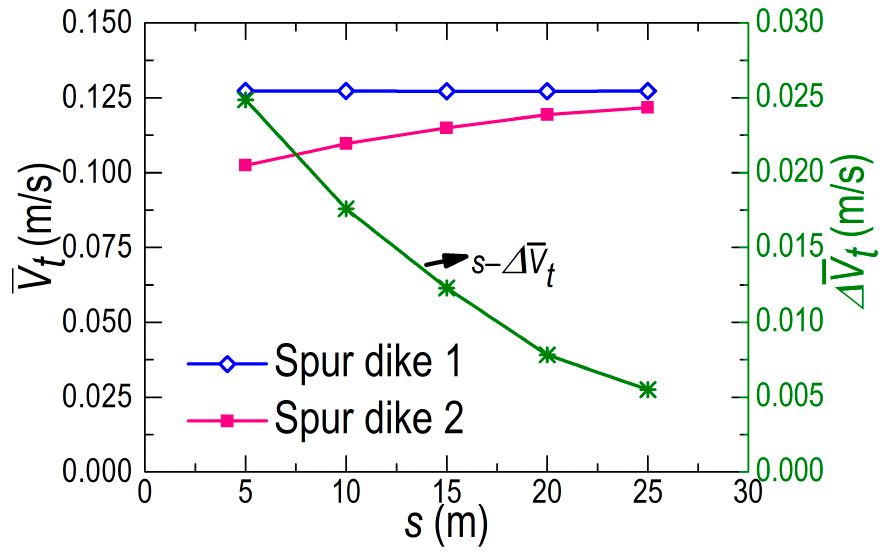
Figure 8. Relations of s – V t and s – ∆ V t